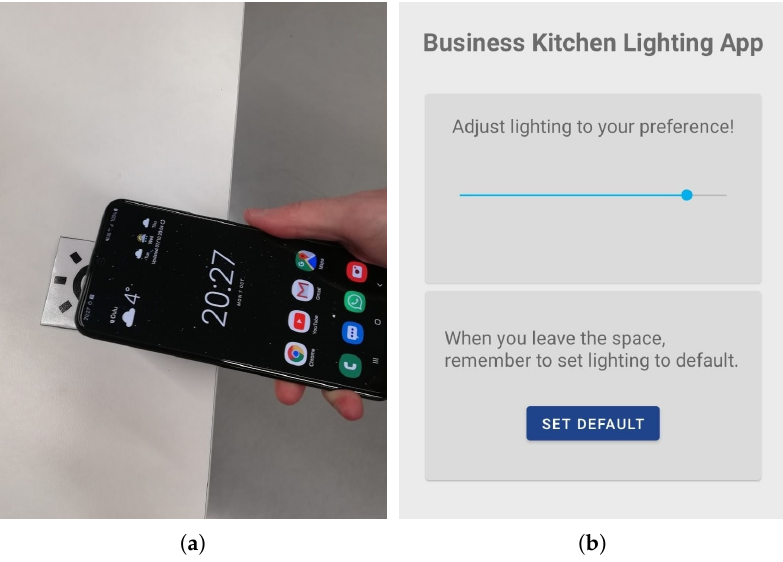
Figure 14. Lighting control prototype: ( a ) Mobile phone touches NFC tag placed on the table; and ( b ) user interface to set the lighting